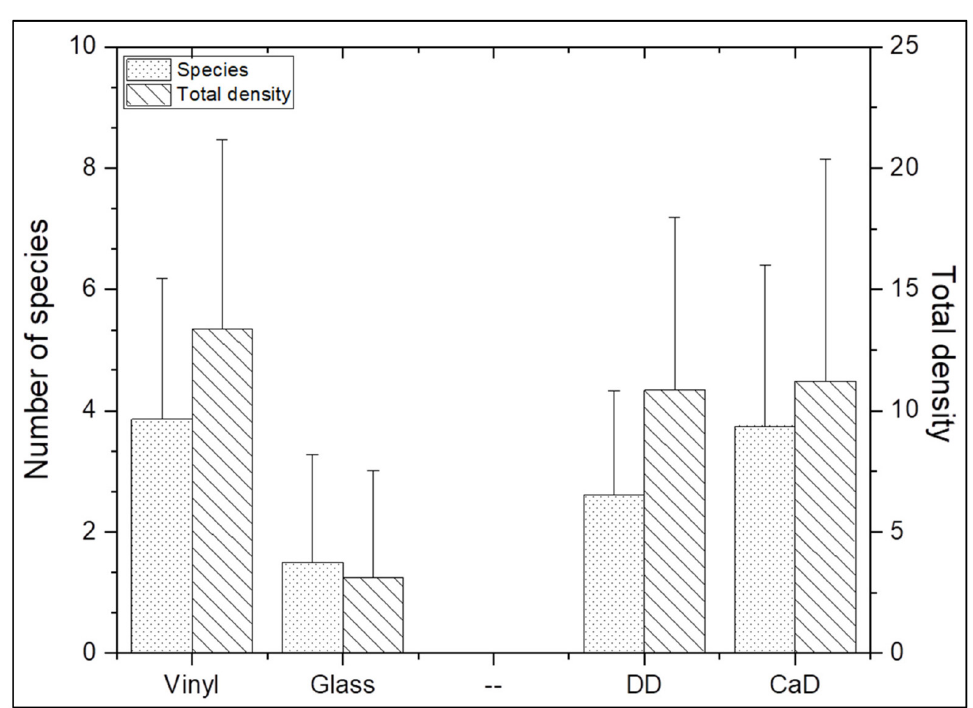
Figure 4. Average density of fungi detected according to the type of greenhouse and drainage. Vinyl: vinyl greenhouse, Glass: glass greenhouse, DD: direct discharge, CaD: collection after